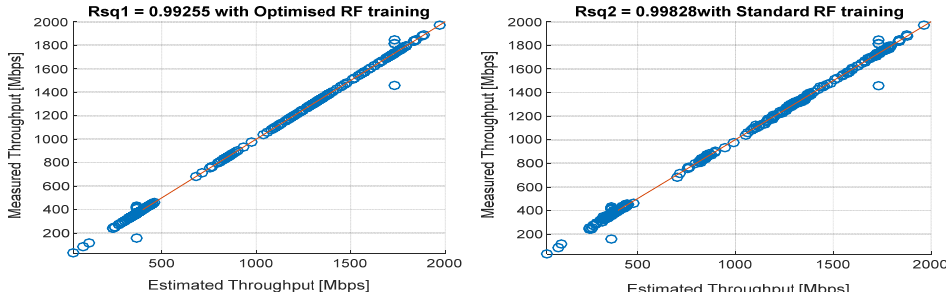
Figure 16. Predicted throughput quality correlation performance of the proposed RF-LS-BPT model and standard RF model at 100 m distance.